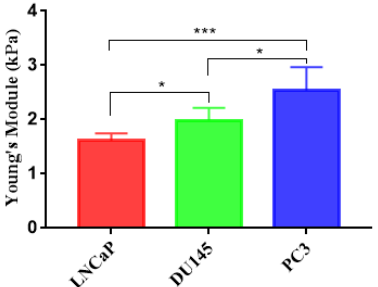
Figure 7. Apparent Young’s modulus of prostate cancer cells were measured using atomic force microscopy (AFM). LNCaP (1.613 ± 0.06403, n = 20), DU145 (1.984 ± 0.112, n = 25), PC3 (2.538 ± 0.2072, n = 25). (* indicates a p value of less than 0.05, *** indicates a p value of less than